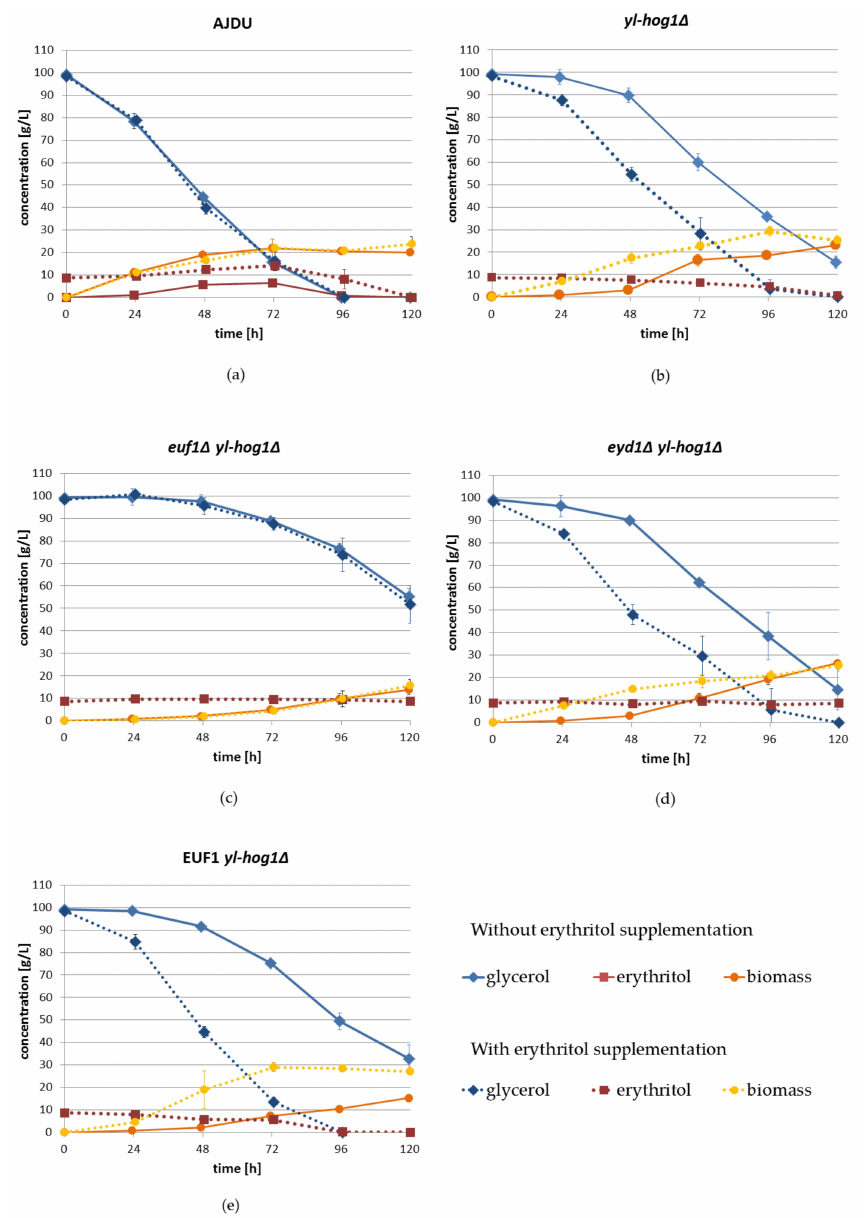
Figure 6. Changes of glycerol, erythritol, and biomass concentration during shake-flask cultures of Y. lipolytica strains: AJDU ( a ), yl-hog1 ∆ ( b ), euf1 ∆ yl-hog1 ∆ ( c ), eyd1 ∆ yl-hog1 ∆ , ( d ) and EUF1 yl-hog1 ∆ ( e ). Results from YNB glycerol (100 g L − 1 ) medium without erythritol are marked with solid line, results from YNB glycerol medium with erythritol (10 g L − 1 ) supplementation and are marked with dotted line. Experiment was conducted in